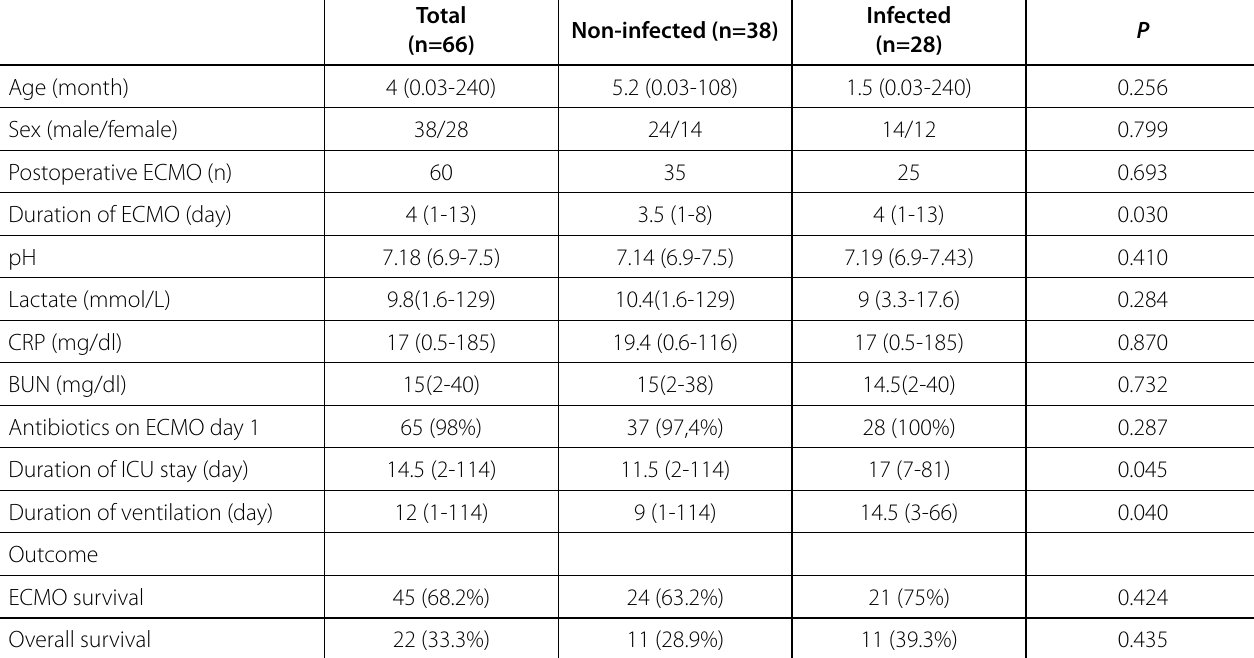
Table 1. Comparison of patient characteristics with and without infectious complications.